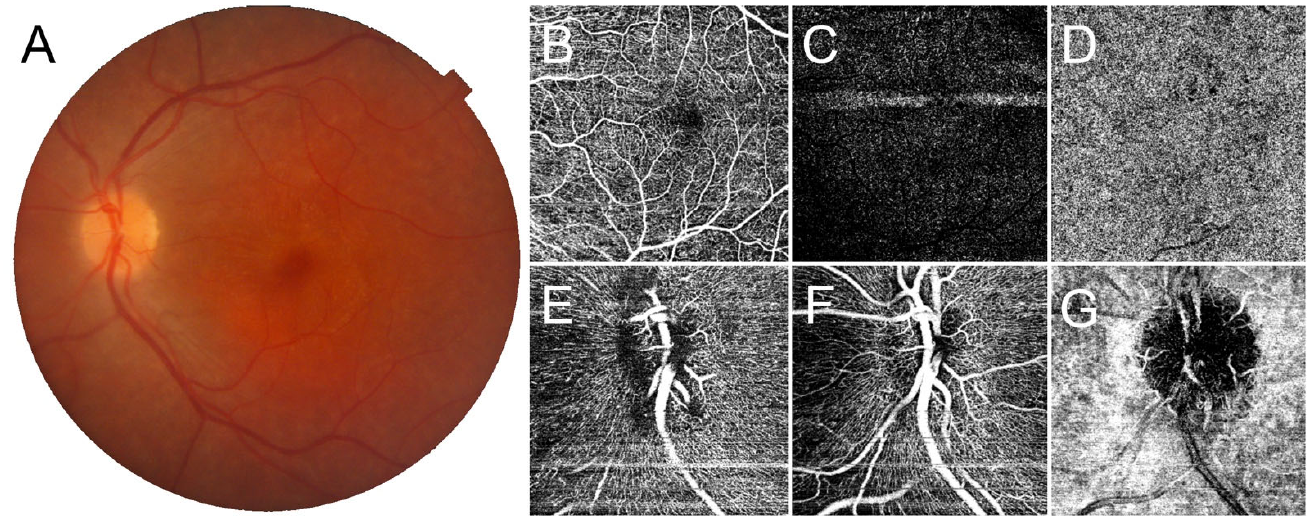
Figure 2. Optical coherence tomography angiography (OCTA) findings in CRB1 ‐ associated retinal dystrophy presenting with macular mottling. Color fundus photography ( A ) is characterized by macular pigmentary alterations in absence of clear atrophy. In the macula, OCTA detects a spared superficial capillary plexus ( B ), markedly disrupted deep capillary plexus ( C ), and choriocapillaris flow voids ( D ). At the level of the optic nerve head, the radial peripapillary capillary plexus appears rarefied ( E ), together with the involvement of the superficial and deep capillary plexus ( F ), while the choriocapillaris appears preserved ( G ).